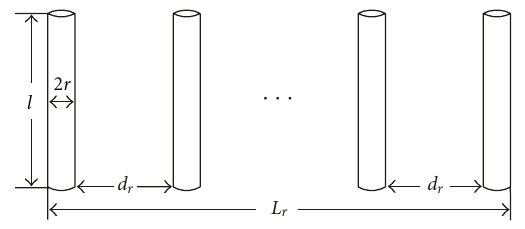
Figure 1: Dipole elements in a side-by-side configuration (receiver antenna array as an